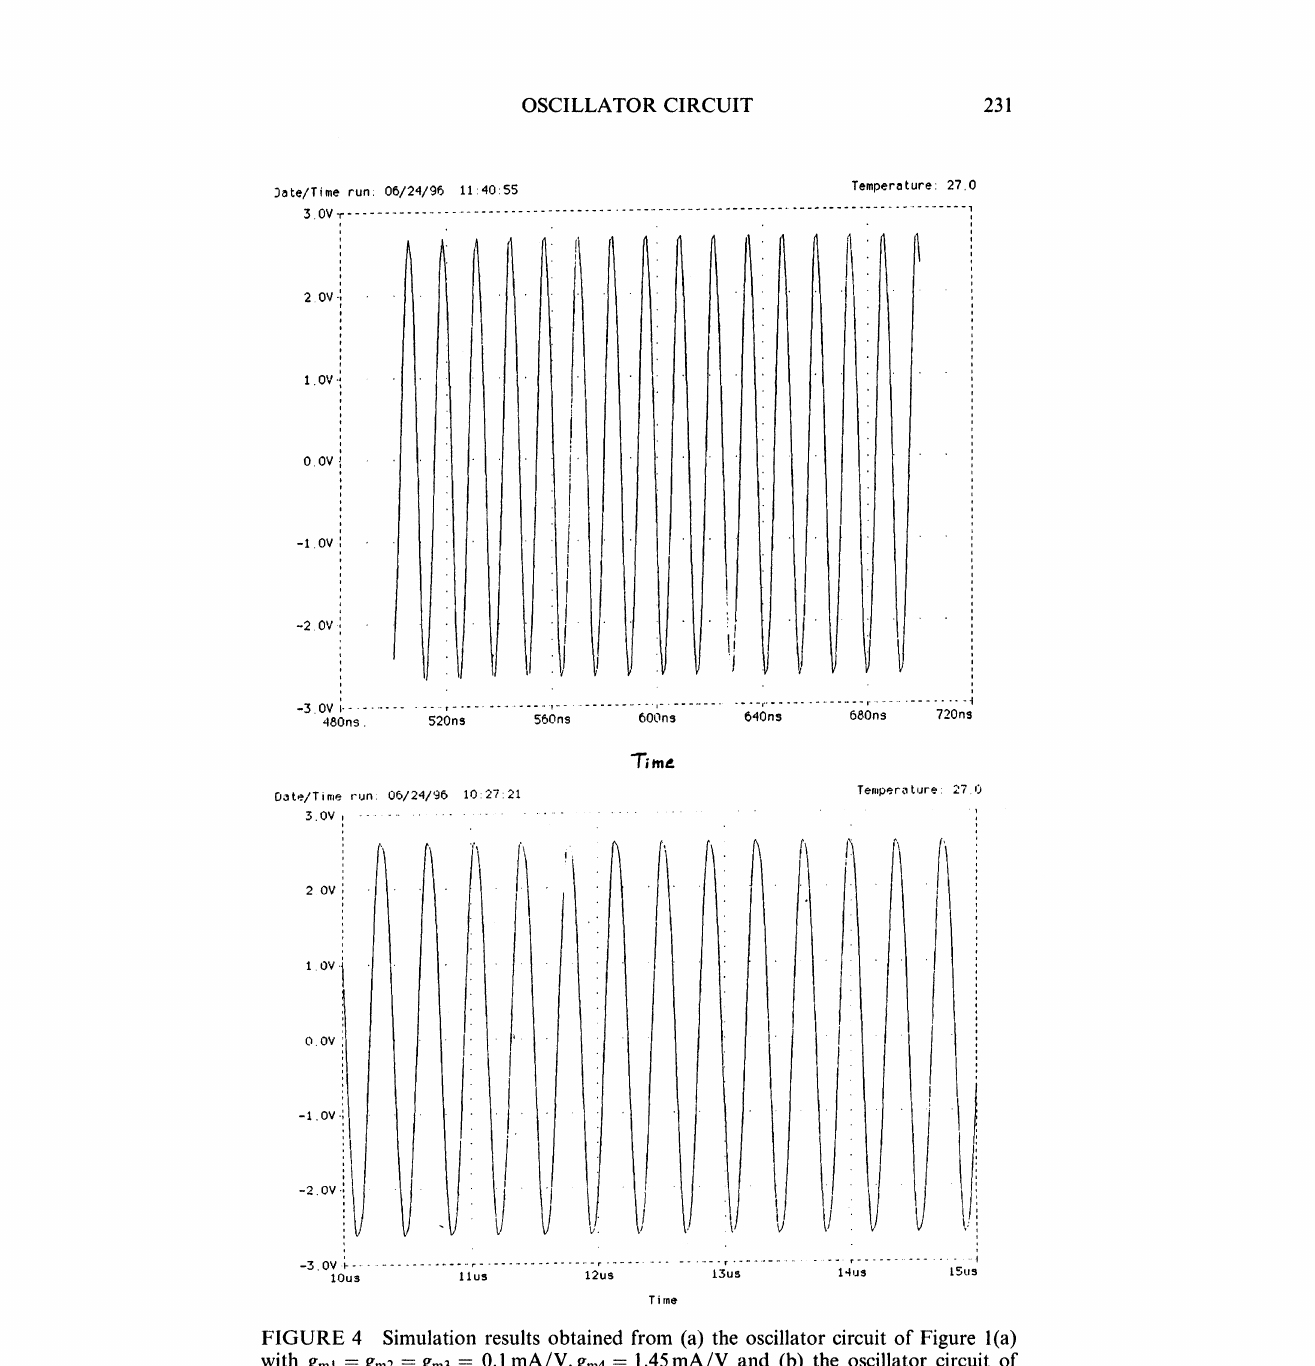
FIGURE 4 Simulation results obtained fronl (a) the oscillator circuit of Figure l(a) with gml --gm2- gm3 0.1 mA/V, gm4- 1.45mA/V and (b) the oscillator circuit of Figure l(b) with